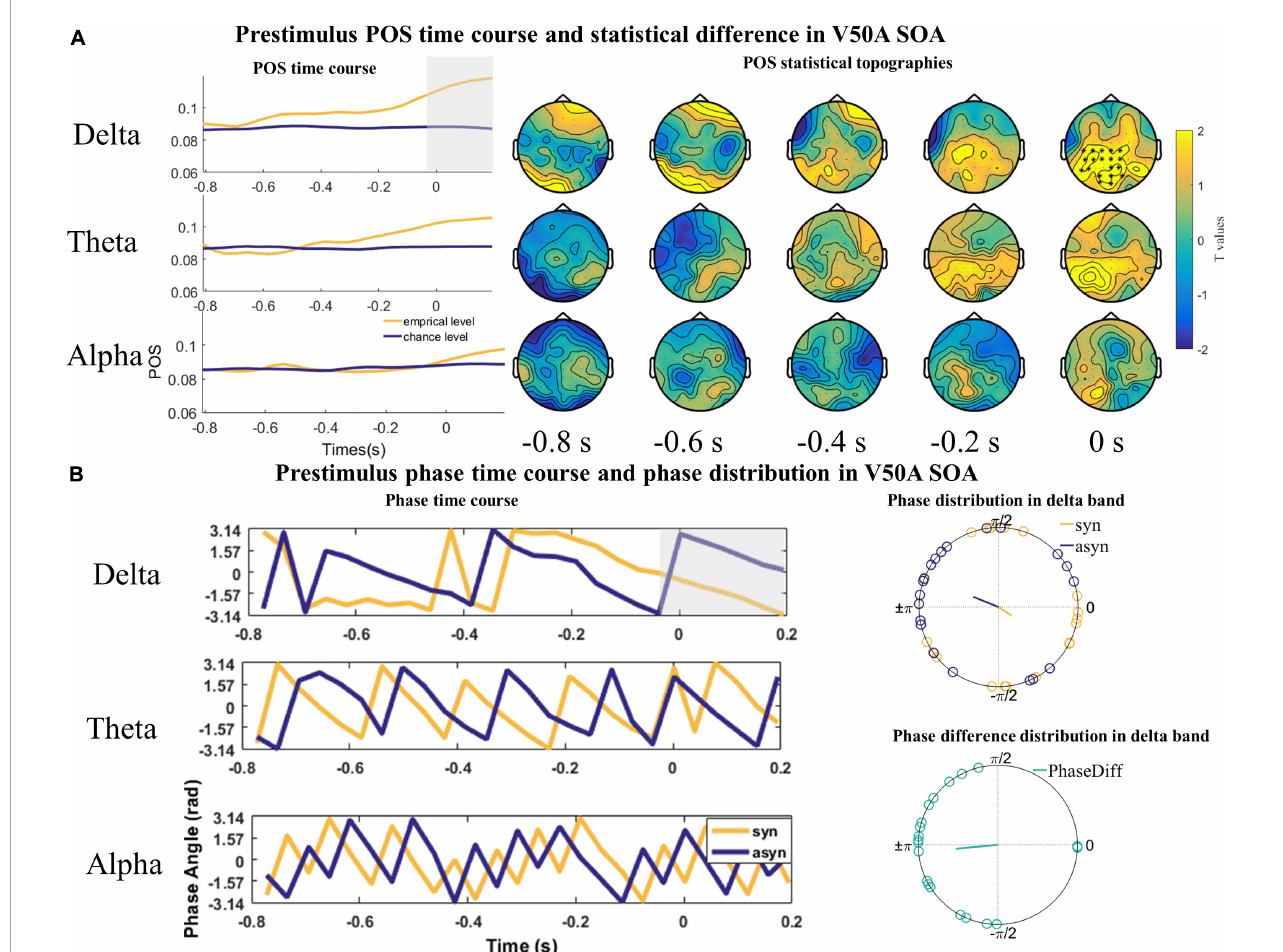
FIGURE5 The statistical difference of phase opposition sum (POS) in the V50A stimulus onset asynchronous (SOA). (A) Left is the time course of empirical and chance level POS in the delta, theta, and alpha band respectively. Each topography shows the average t-map across a 200 ms temporal window starting at the indicated time point. Time 0 s indicates the onset of visual signals. (B) The time courses of phases extracted from and averaged over the cluster (delta) or the whole channels (theta and alpha) across subjects were shown on the left. The mean phases and phase differences are plotted for each participant in the delta band on the right. The orange, blue, and green lines indicate the mean resultant vector lengths (MRVLs). Gray-shaded areas indicate the timeframes with significant differences. Significant channels are highlighted with